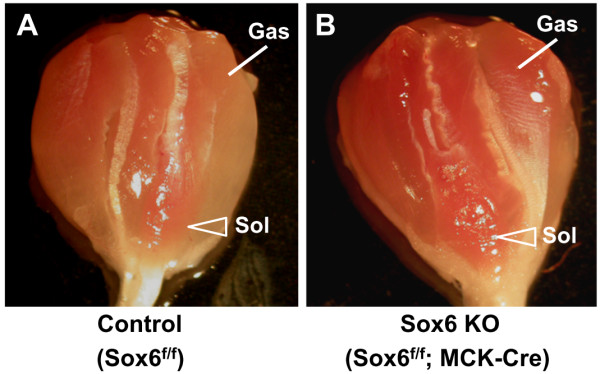
Morphological difference of skeletal muscle between control and Sox6 KO mice. Dissected gastrocnemius/soleus muscles from three month old mice are shown. A. control (Sox6f/f) muscle. B. Sox6 KO (Sox6f/f; MCK-Cre) muscle.